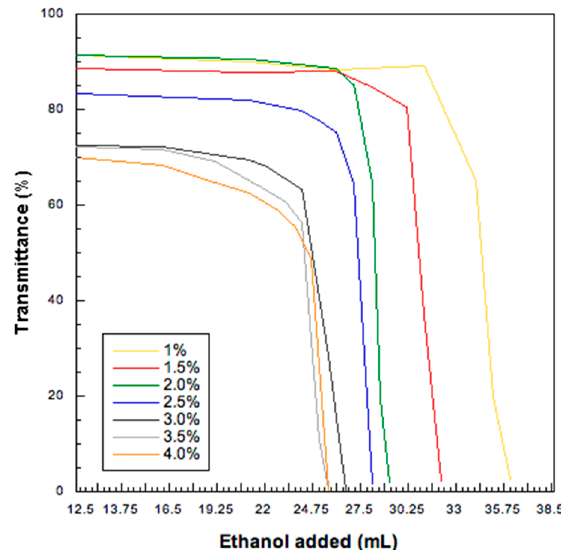
Figure 1. Transmittance values (%) as a function of ethanol volume added for six sodium hyaluronate aqueous solutions at different concentration concentrations (starting HA concentration from 1.0 to 4.0% w / v .